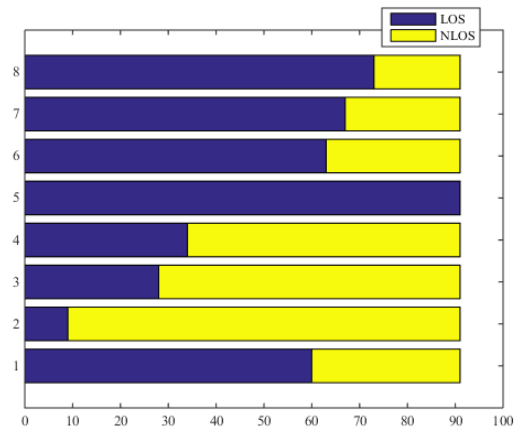
Figure 5. The sight state in sample points.